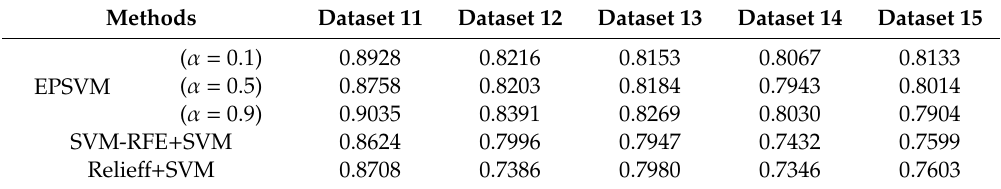
Table 6. The mean NER of di ff erent methods for platelet